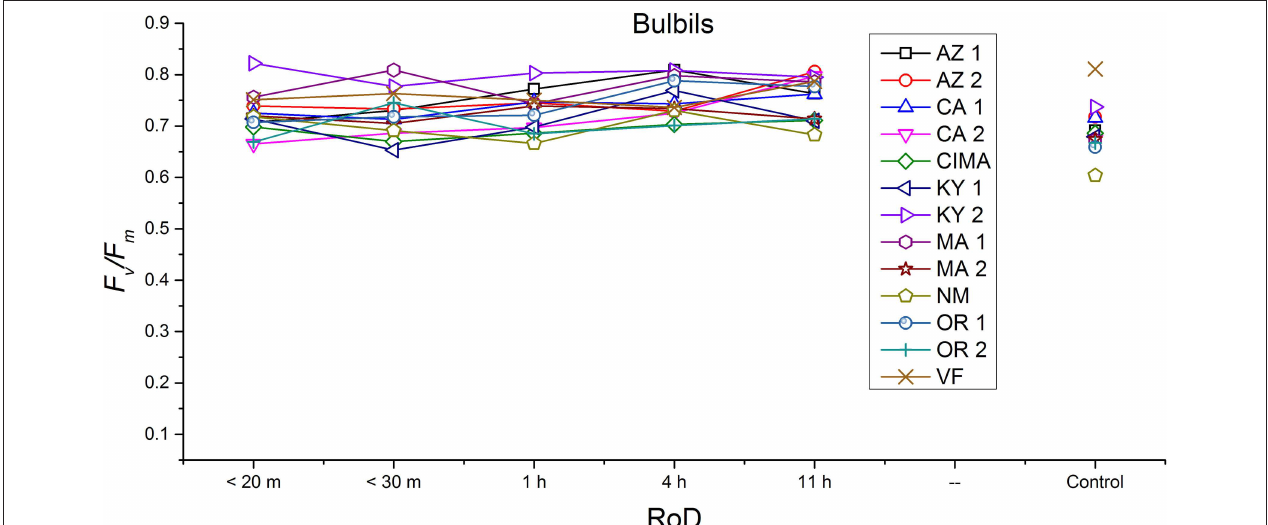
FIGURE 8 | Reaction norms for bulbils from 13 ecotypes exposed to five rates of drying (RoD) 24h post